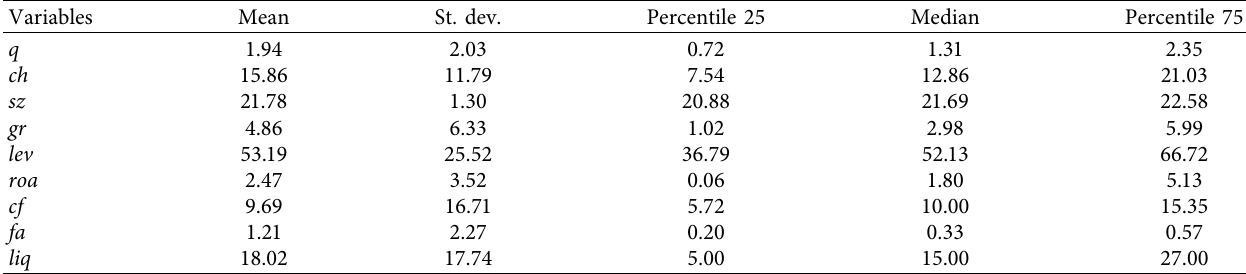
Table 1: Summary statistics of variables.